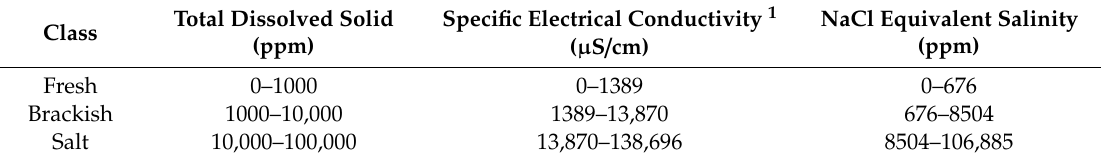
Table 2. Classification of water based on total dissolved solids [52], range of specific electrical conductivity, and NaCl equivalent salinity